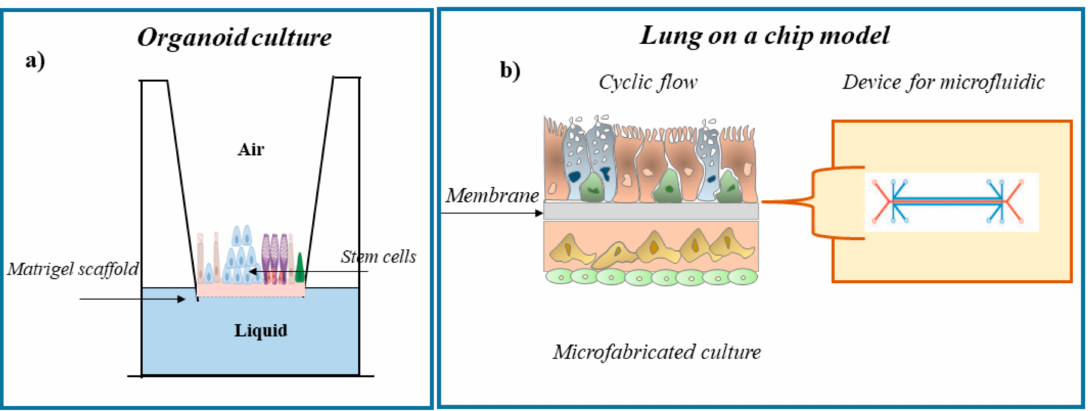
Figure 4. Cell-based in vitro lung models for the study of inhalation toxicity. Visual representation of three-dimensional in vitro models of each model system for the study of inhalation toxicity: ( a ) organoid culture and ( b ) microfluidic and microfabricated device culture. ECM, extracellular